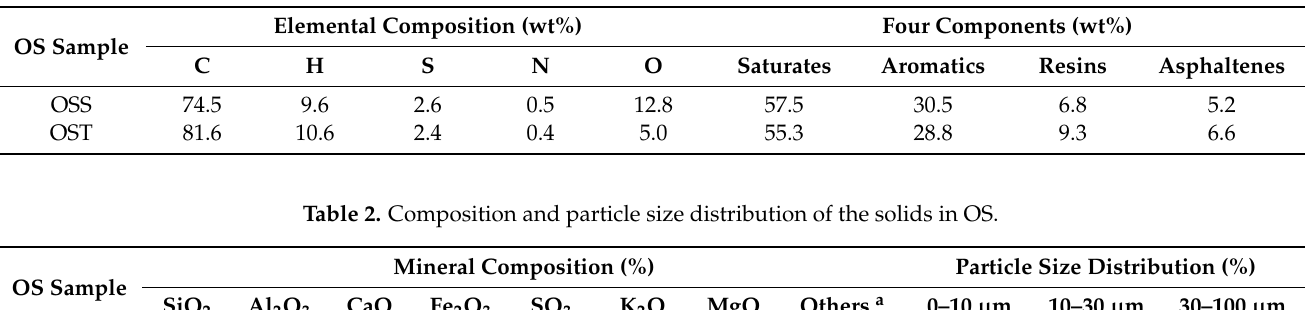
Table 2. Composition and particle size distribution of the solids in OS.